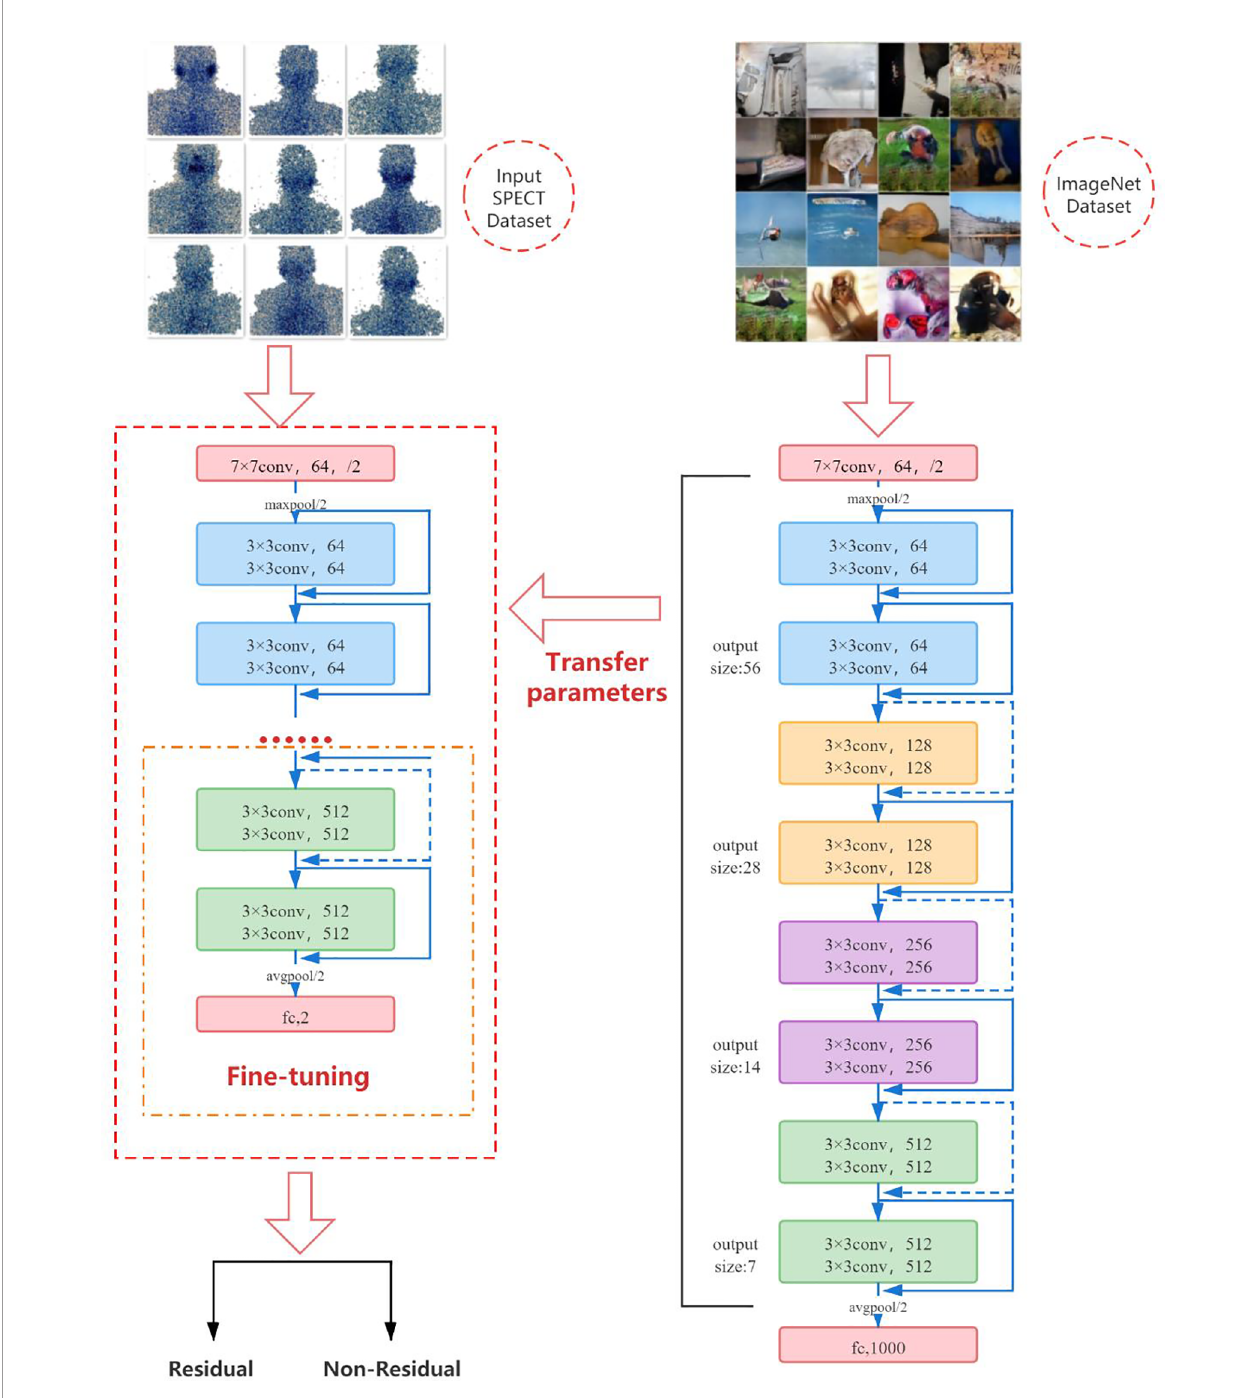
FIGURE 8 | The fi ne-tuning process of the